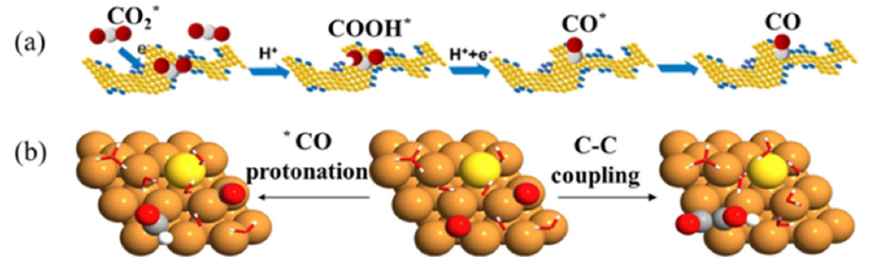
Figure 7. ( a ) Schematic diagram of the path of electroreduction of CO 2 to CO [86]. ( b ) Competition between *CO protonation and C ‐ C coupling on the Au ‐ Cu surface [92].